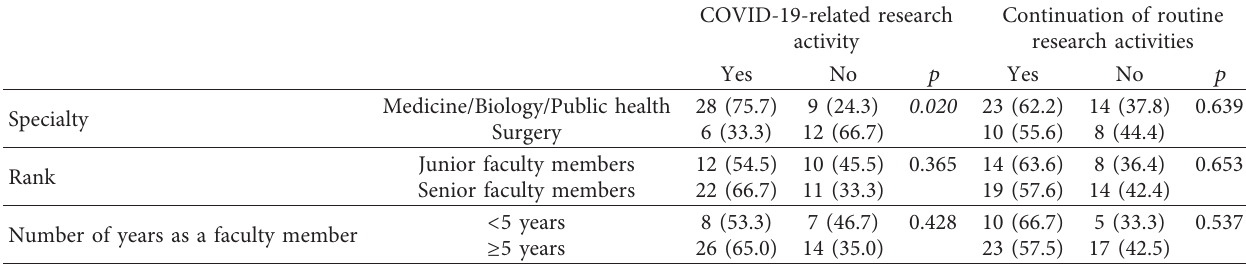
Table 4: Factors associated with research activity during the COVID-19 pandemic among faculty